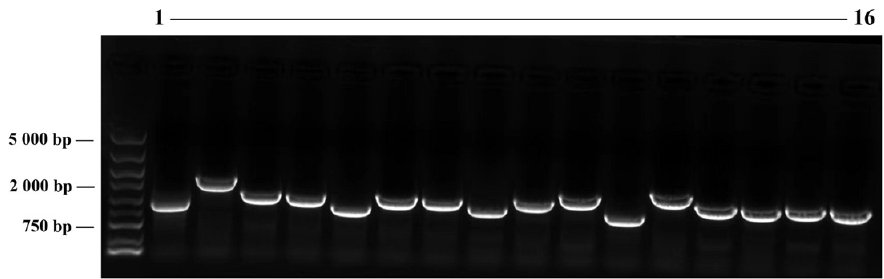
Figure 2. Identification of insert length and recombination rate of cDNA libraries. 1–16: sixteen monoclones were randomly selected for colony PCR detection, and the PCR products were detected by 1% agarose gel electrophoresis. Table 2. Photosynthesis-related proteins identified to interact with slToc159-1 and slToc159-2 in a split-ubiquitin yeast two-hybrid screen.